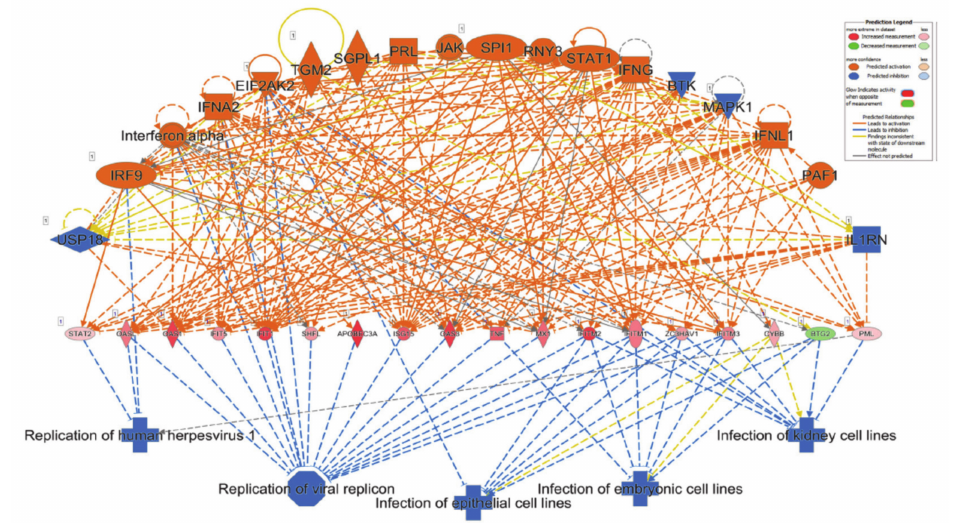
Figure 7. Suppression of viral infection and replication based on transcriptome and IPA analysis of lung-derived tissue from COVID-19 patient. Regulator e ff ects network analysis based on IPA revealed suppression of viral infection and replication in lung tissue from patients with SASRS-COV-2 infection. Network highlights a role for BTK, EIF2AK2, IFNA2, IFNG, IFNL1, IL1RN, Interferon α , IRF9, JAK, MAPK1, PAF1, PRL, RNY3, SGPL1, SPI1, STAT1, TGM2 and USP18 in mediating these inhibitory e ff ects as illustrated. Activation state is depicted according to the color